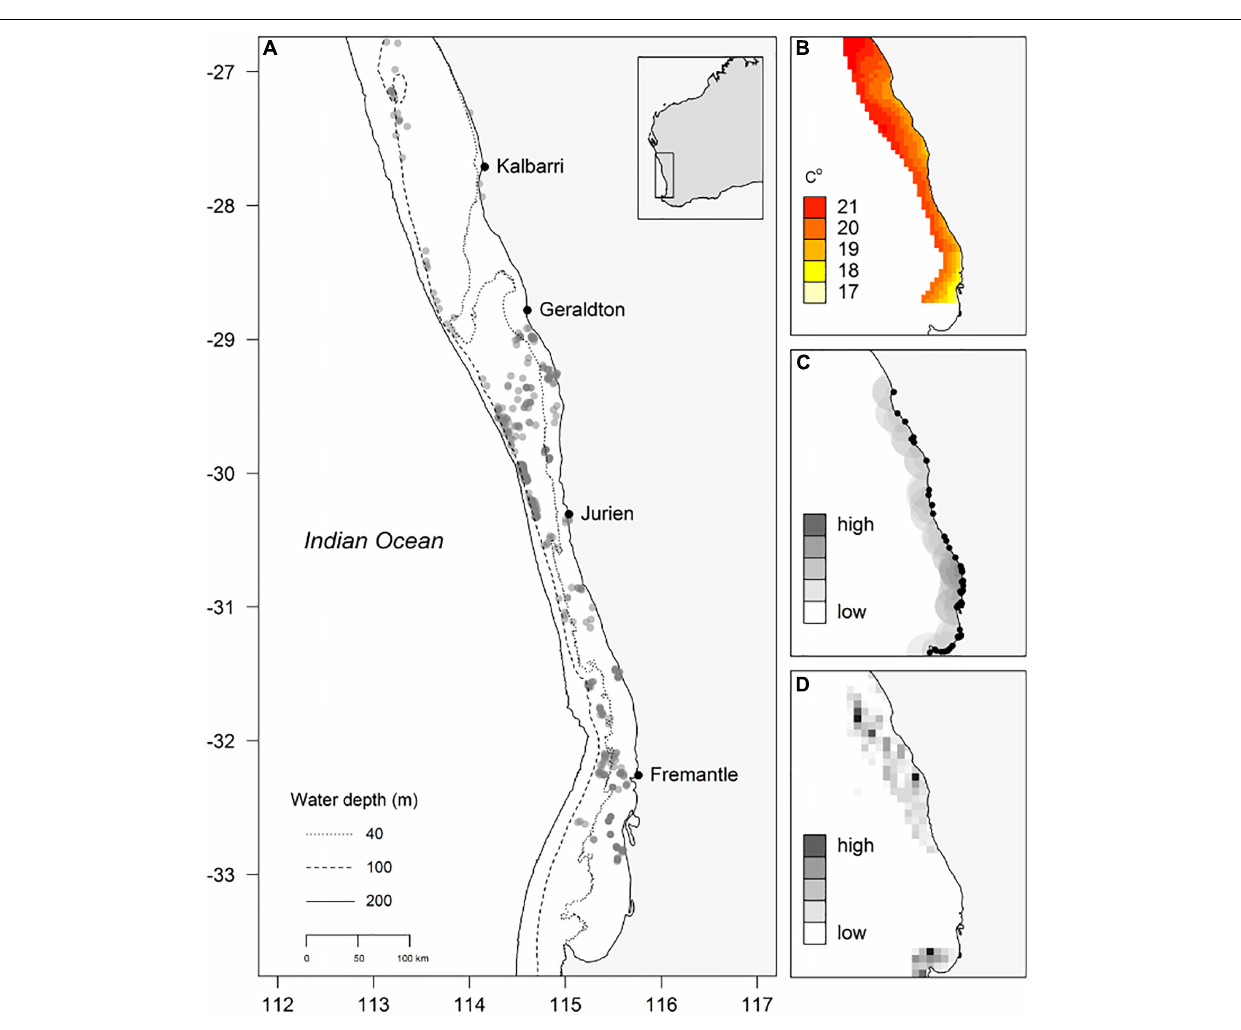
( ∼ 26.5 ◦ S to 33 ◦ S; Figure 1A ). The orientation and scale